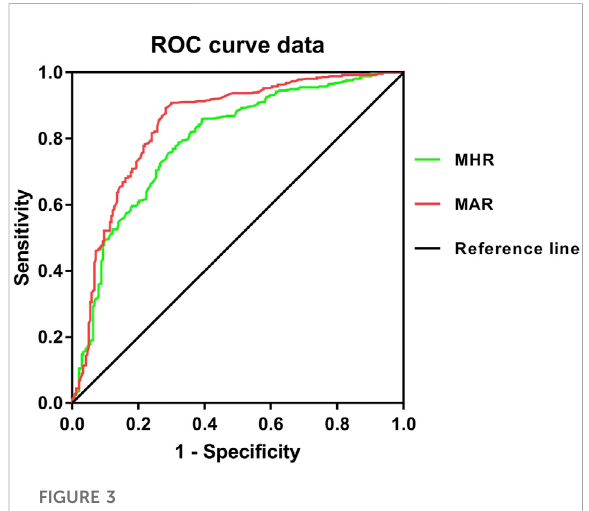
FIGURE 3 Receiver operating characteristic curves for the cutoff value of MHR and MAR identifying